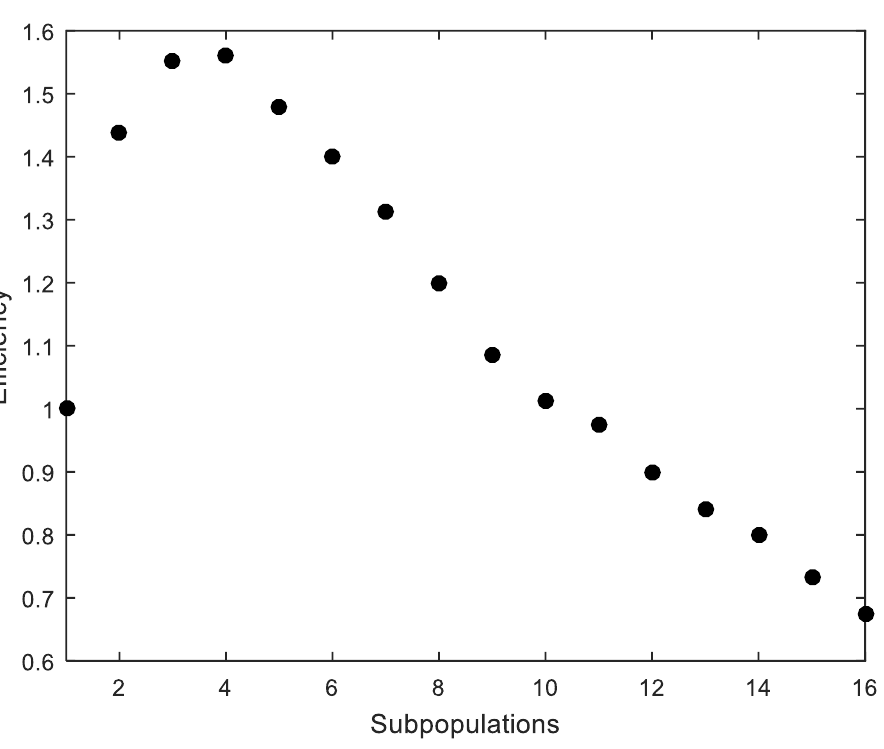
Figure 9. Cross-section under biaxial bending. Efficiency.